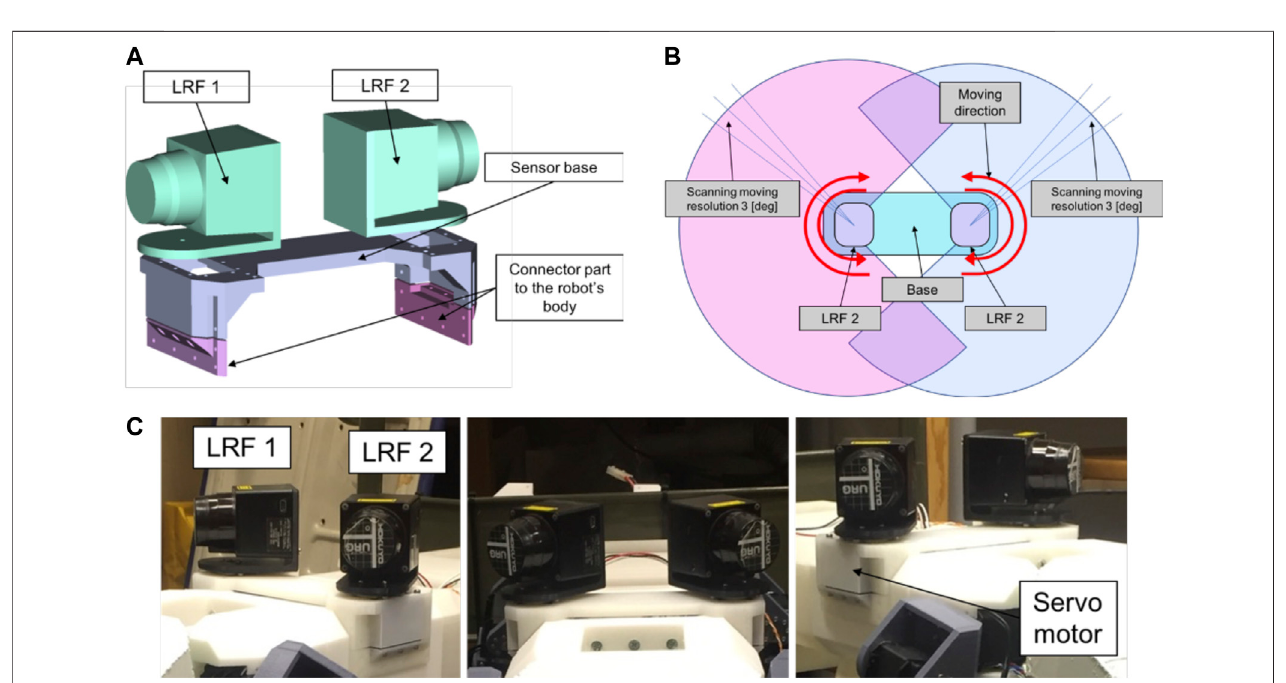
FIGURE6| Thequad-compositetime-of- fl ightsensors. (A) Headhousing;thesensorsaremountedinsidethedownward-facingslits. (B) Headcap. (C) Thehead with installed sensors.